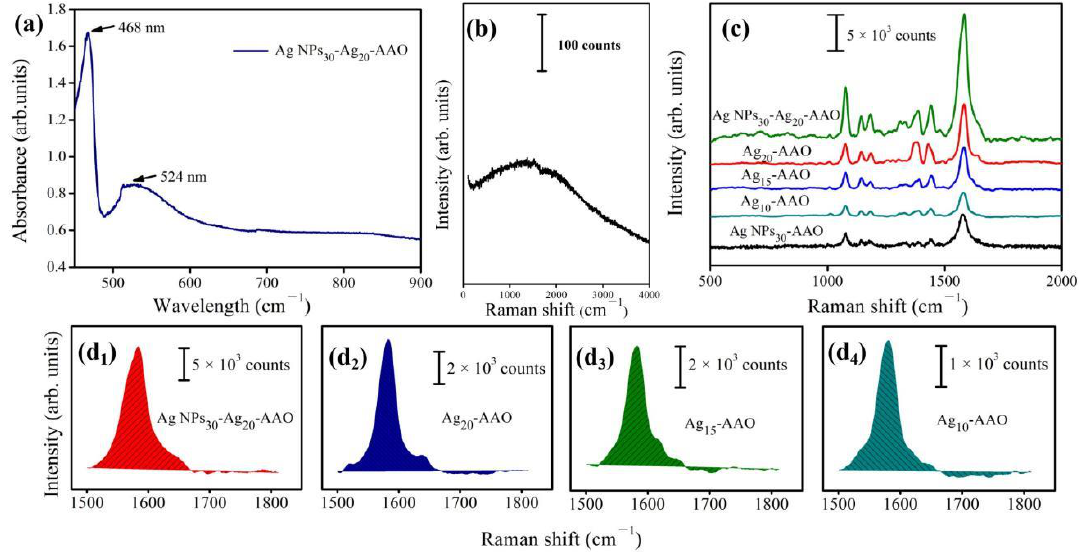
Figure 7. ( a ) UV-vis extinction spectra of the Ag NPs 30 -Ag 20 -AAO substrate; ( b ) Raman spectra of the bare AgNPs 30 -Ag 20 - AAO substrate; ( c ) Raman spectra of the 4-aminothiophenol on different types of SERS substrates; ( d 1 – d 4 ) the integrated integral area of the Raman shift in the range of 1502 cm −1 –1811 cm −1 . Table 1. Raman intensities of different SERS substrates at the peak of 1582 cm −1 . Sputtering Time